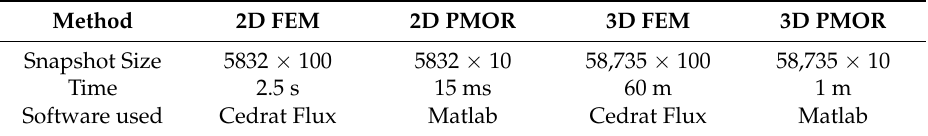
Table 2. Analysis summary and timing.